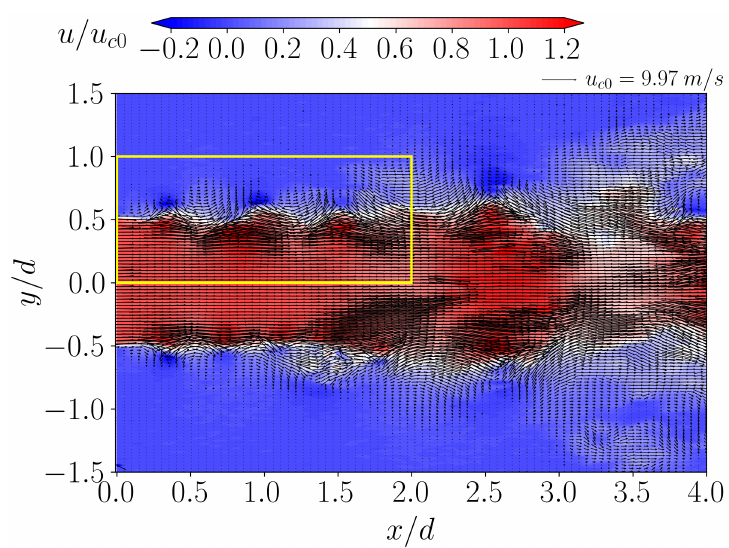
Figure 5. Instantaneous velocity vectors overlaid on the instantaneous axial velocity contour u / u c0 , with the DMD sub-domain highlighted by the yellow